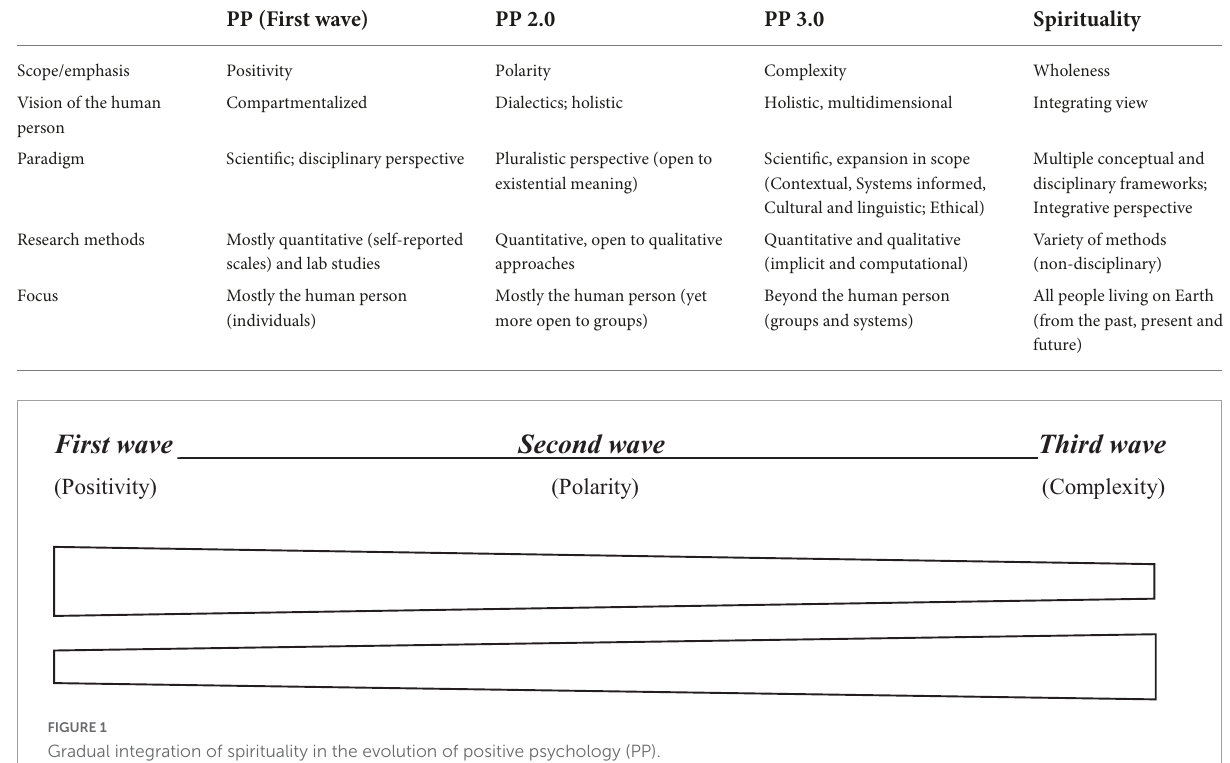
FIGURE1 Gradual integration of spirituality in the evolution of positive psychology (PP).